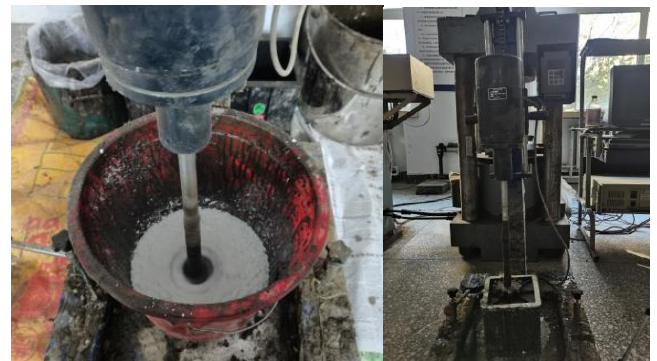
Figure 2. High-speed dispersion